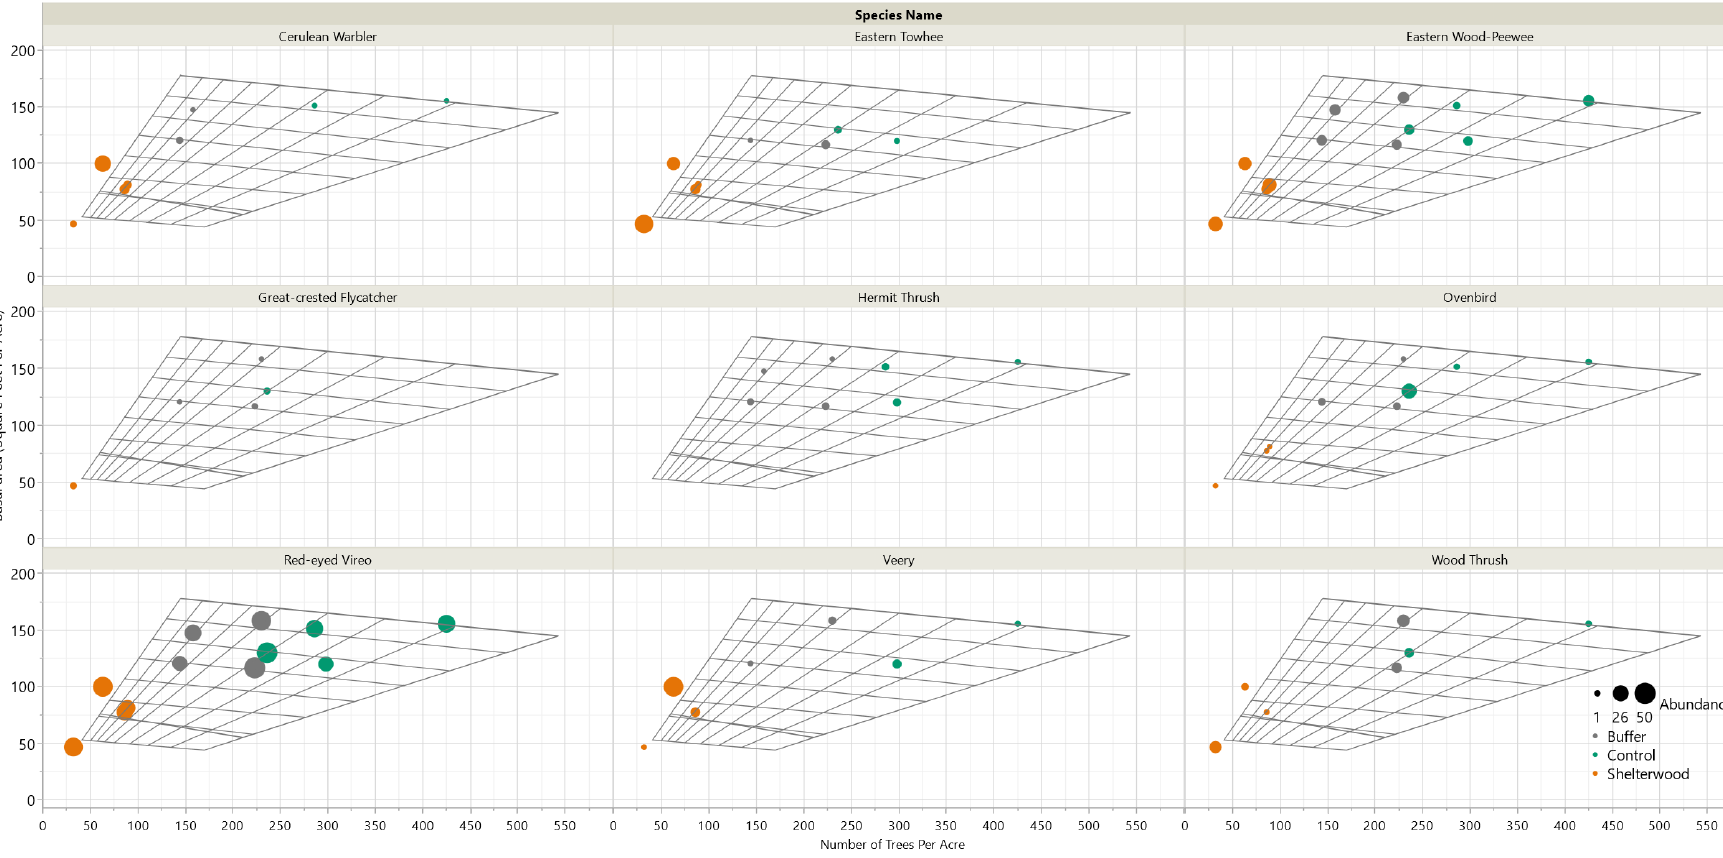
Figure 13. Density (birds/100 acres) of 9 common bird species in Northern Oak forests of western Pennsylvania (Stoleson, unpublished data) plotted, as dots, on a Gingrich stocking chart for Northern Red Oaks [122]. Uncut control stands (see inset figure legend) were typical of forests in the region with 70–100% stocking and much of the basal area in small diameter trees. Shelterwood stands (orange dots) had reduced basal areas and a greater proportion of the basal area in larger diameter trees.